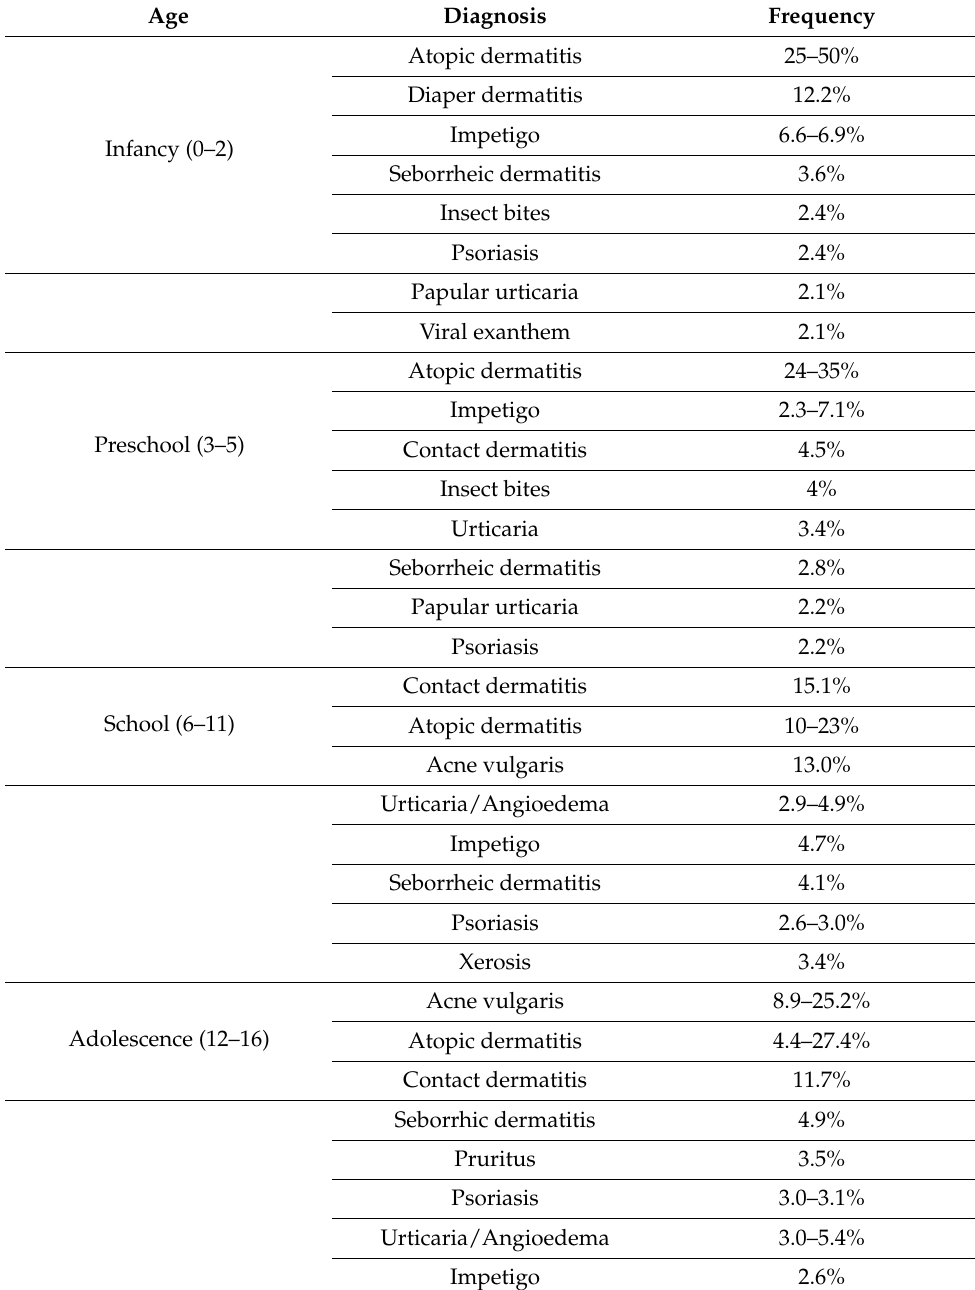
Table 1. Classification of skin diseases with itching in children and